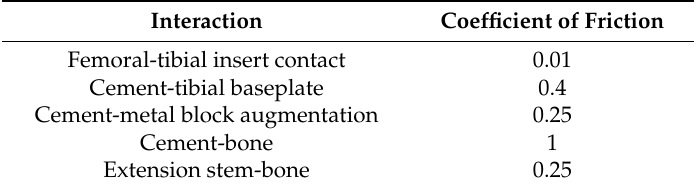
Figure 2. ( A ) Loading patterns for various activities of daily living (ADLs). The vertical force was selected with the maximum magnitude at desired flexion angle. The moment was selected corresponding to vertical force. ( B ) The contact locations between femoral and tibia insert components over the knee flexion angles. ( C ) The force ratio between the medial and lateral condyles for the knee flexion angles. Table 2. A coefficient of the friction applied to the surface contact conditions.